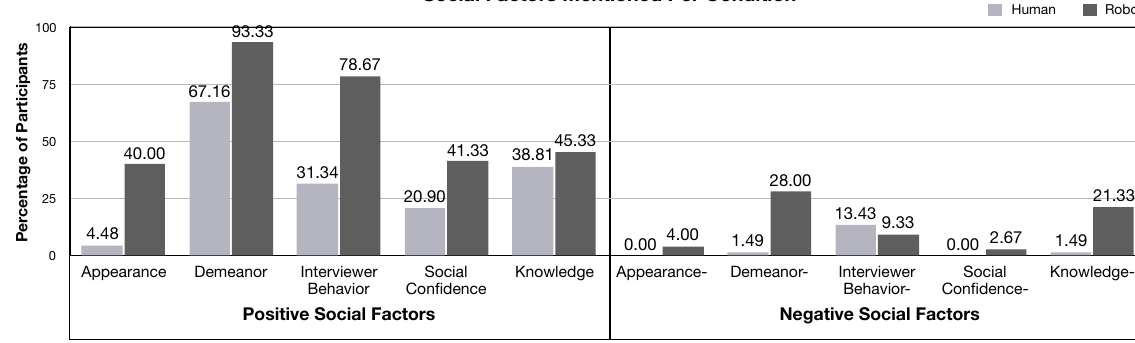
Figure 8: Positive and negative mentions of each social factor for human and robot interviewers.